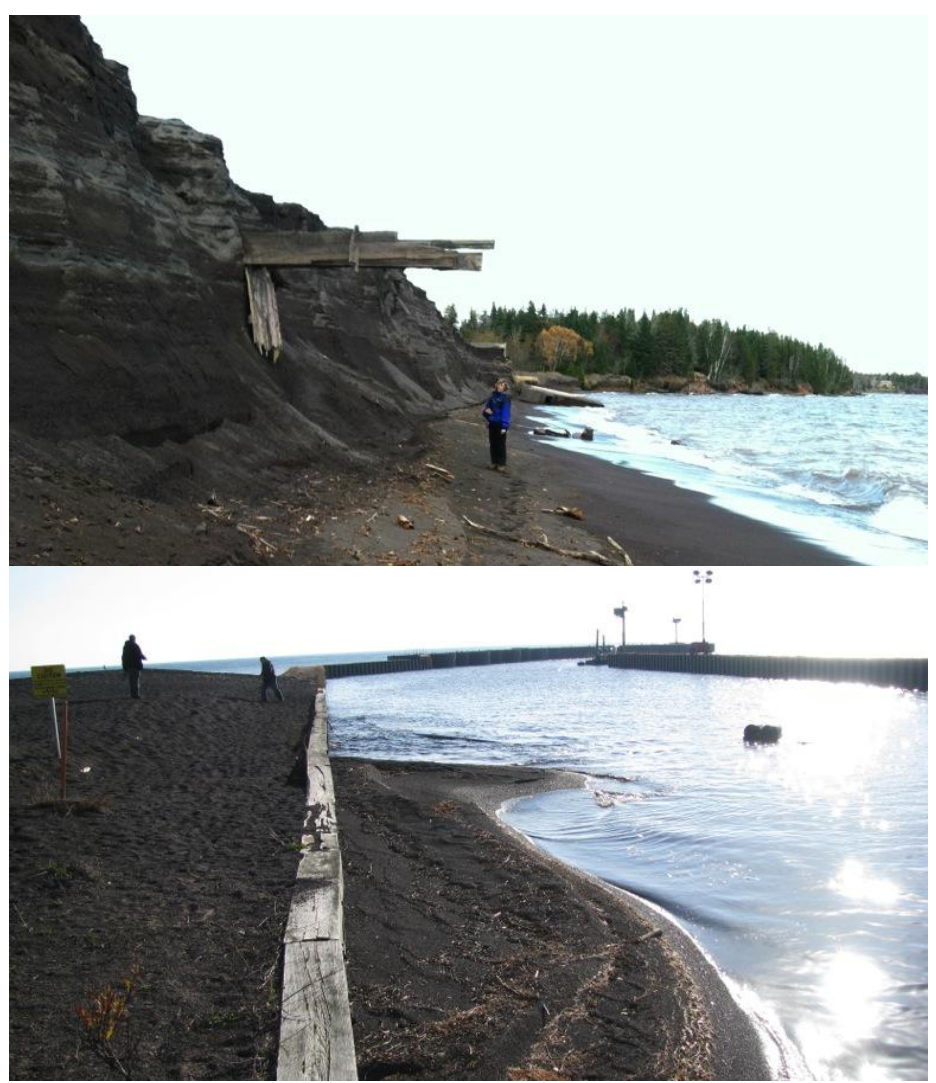
the ( Below ) Traverse River Seawall, spilling into the Traverse River